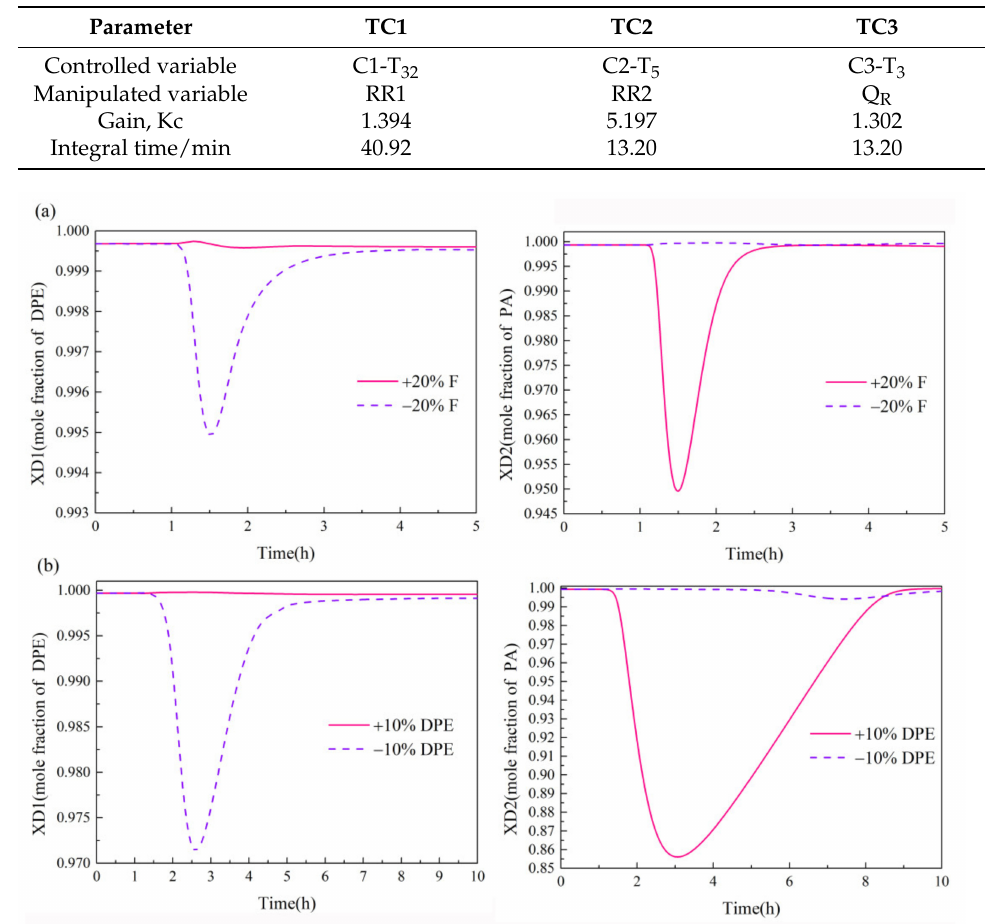
Table 2. Tuning parameters of temperature controllers in CS1.